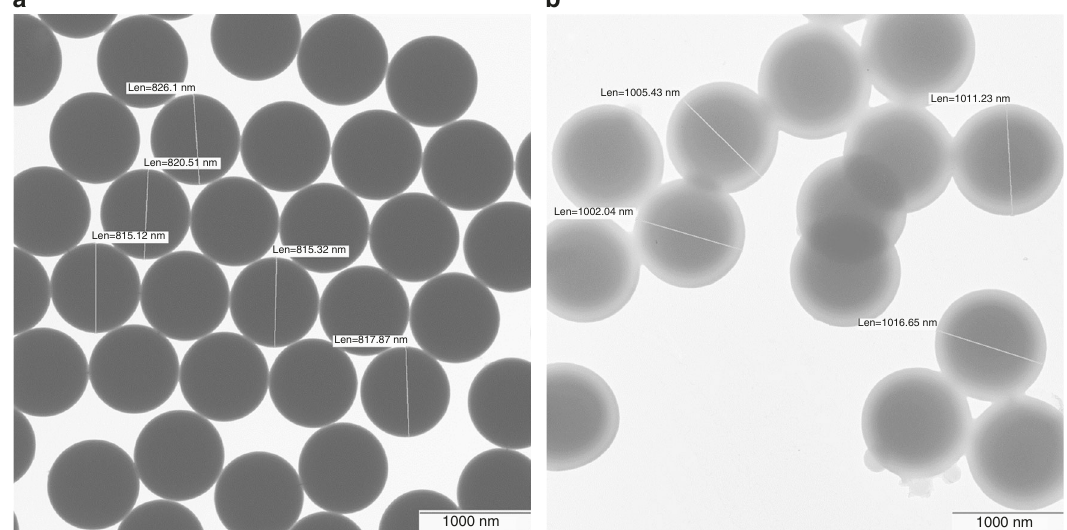
Fig. 6 Electron microscopic images of targets: a polystyrene spheres and b hollow spheres made of polymethylmethacrylate